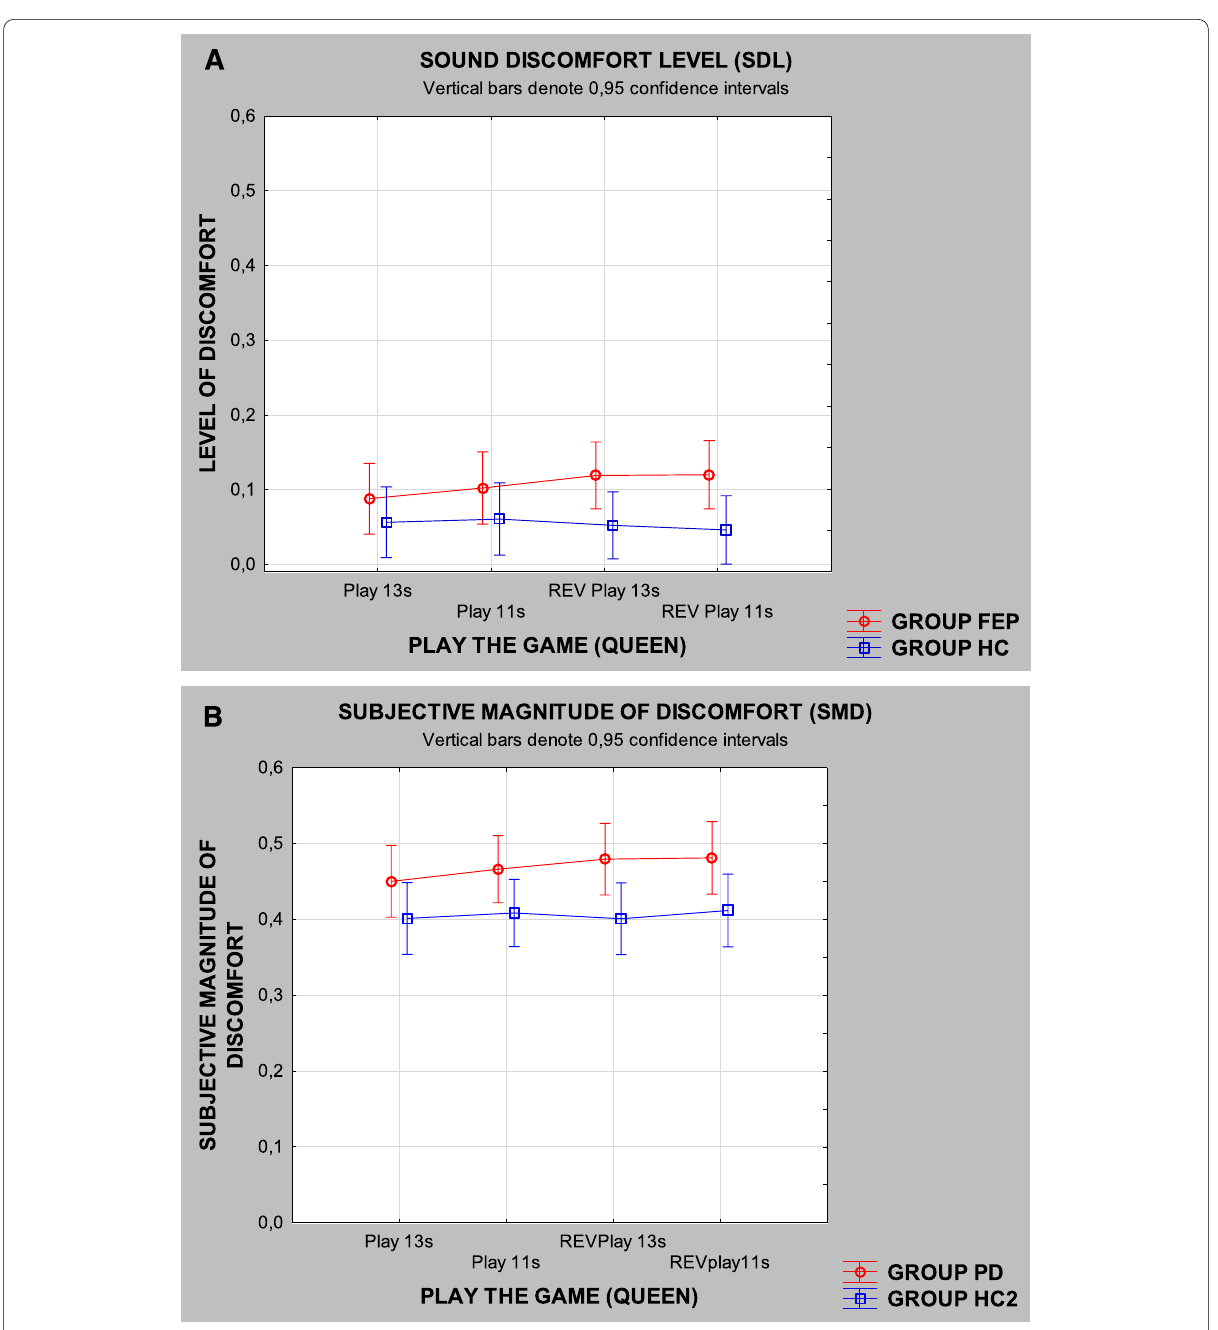
Fig. 3 Mean SDL attributed to sequences from “Play the Game,” forward and reverse, by FEP vs HC A and mean SMD attributed by PD vs HC2 B to the same